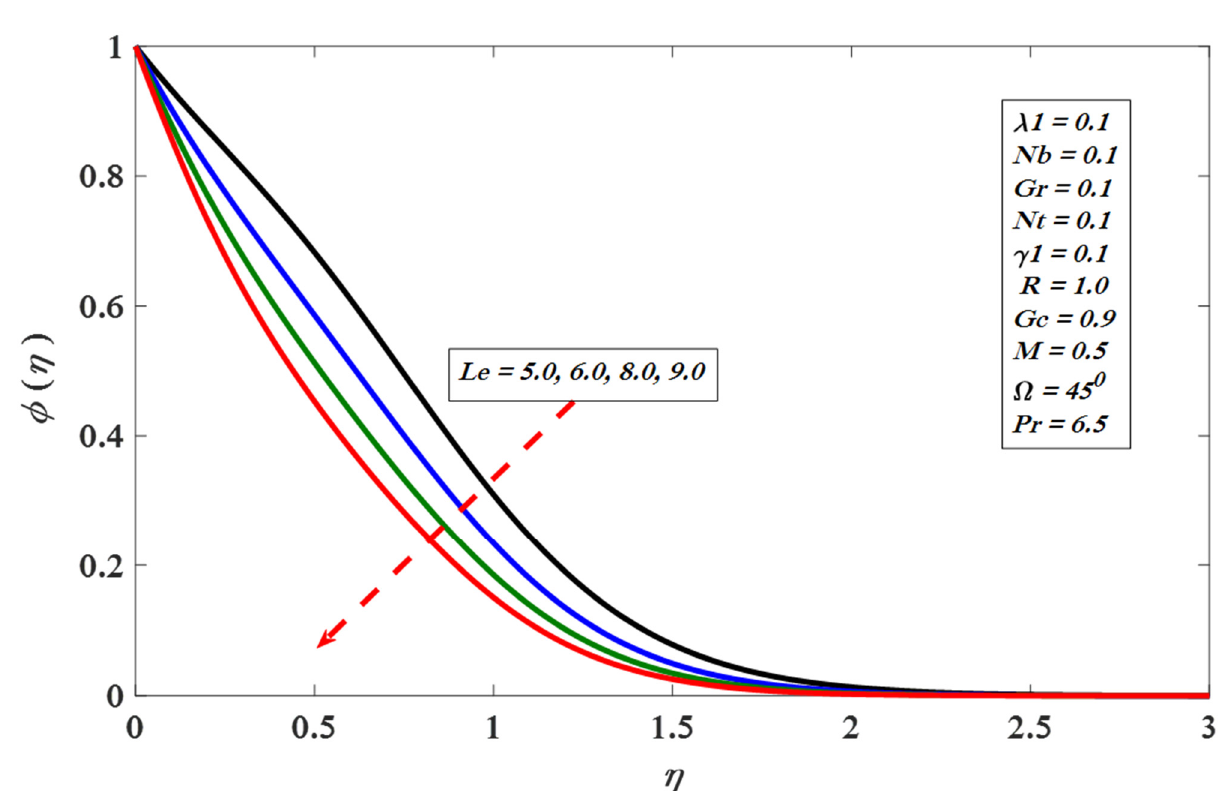
Figure 14. Concentration profile versus Le